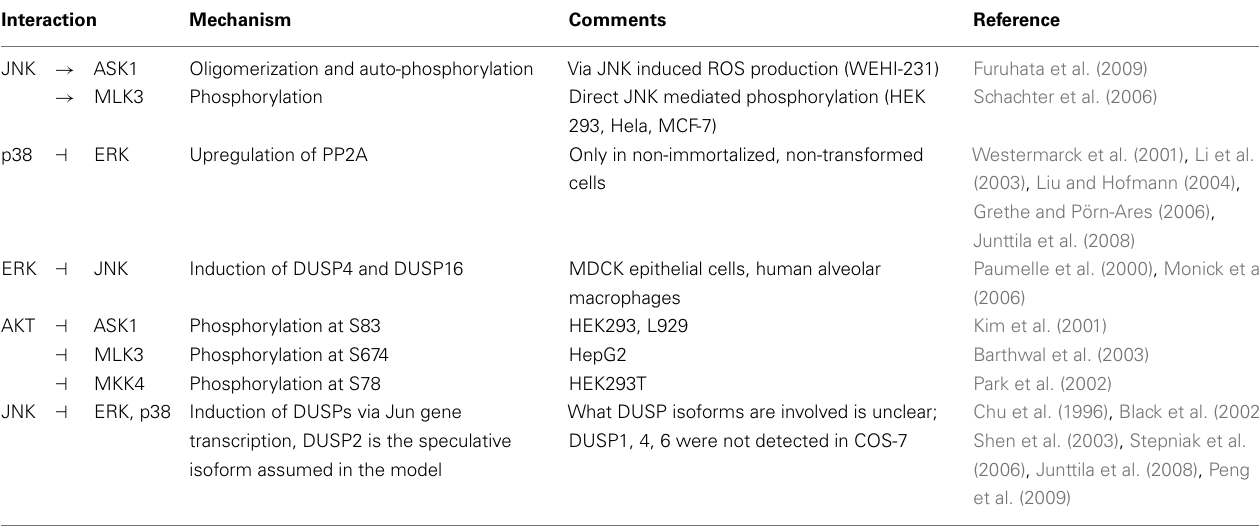
Table 1 | Crosstalks and feedbacks in the nominal MAPK interaction model.